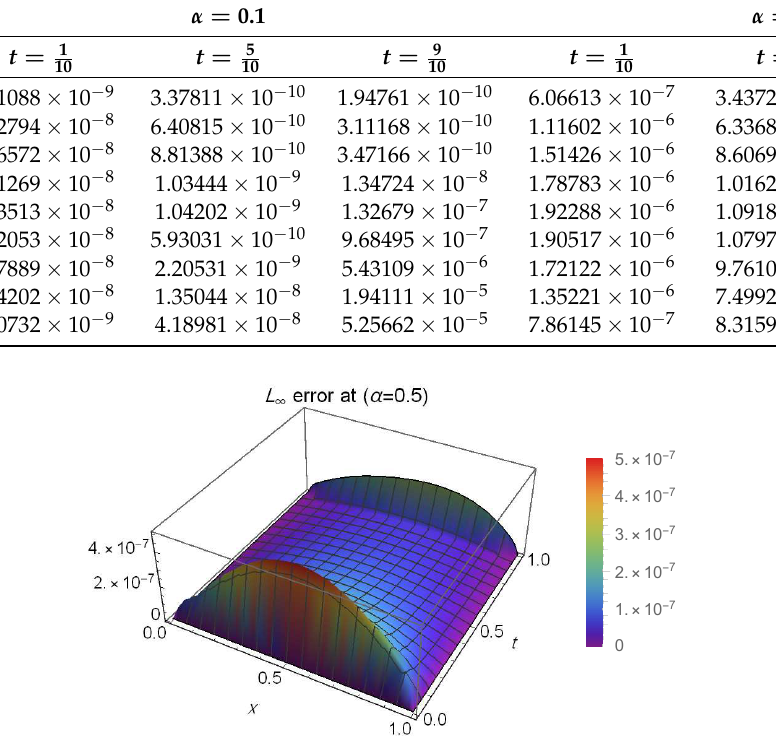
Figure 3. Th L ∞ error for Example